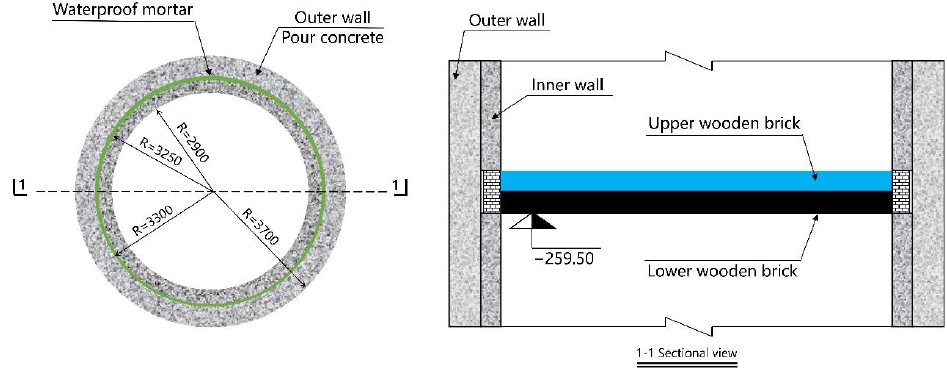
Figure 15. Schematic diagram of shaft-lining-damage prevention by cutting pressure-relief groove